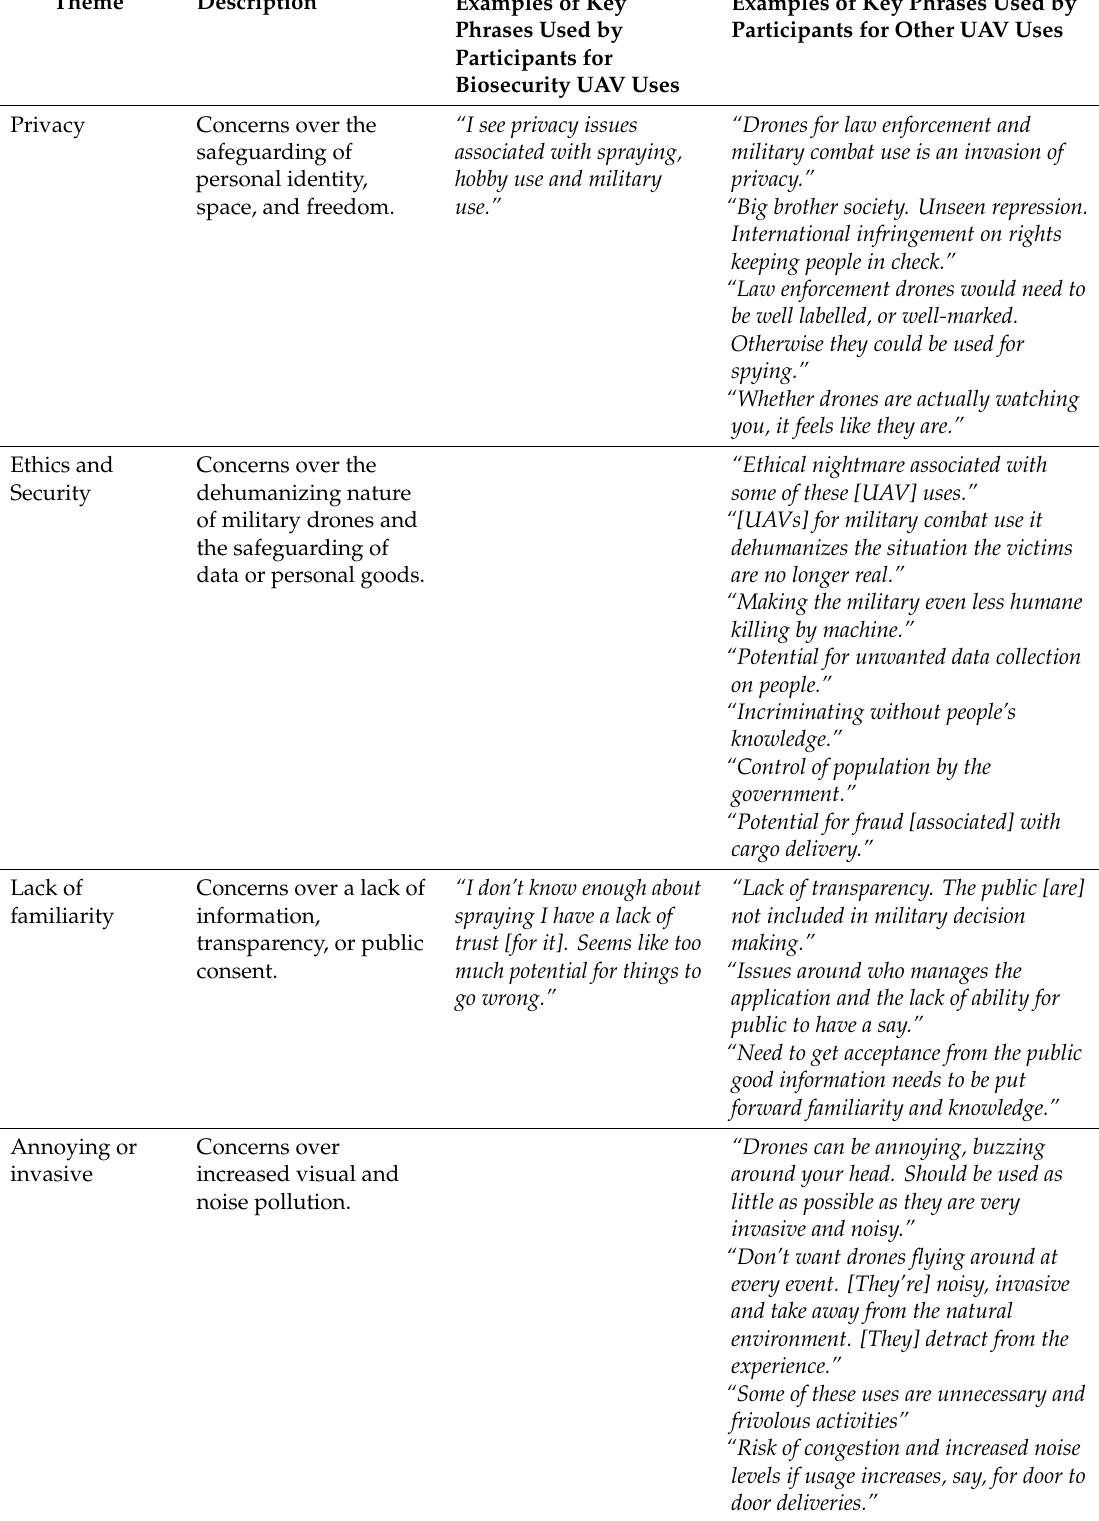
Table 1. Examples of key phrases used to describe the five most prominent themes associated with participants’ perception of the negative aspects of UAVs, both for biosecurity-specific uses and for the other 12 use categories that were